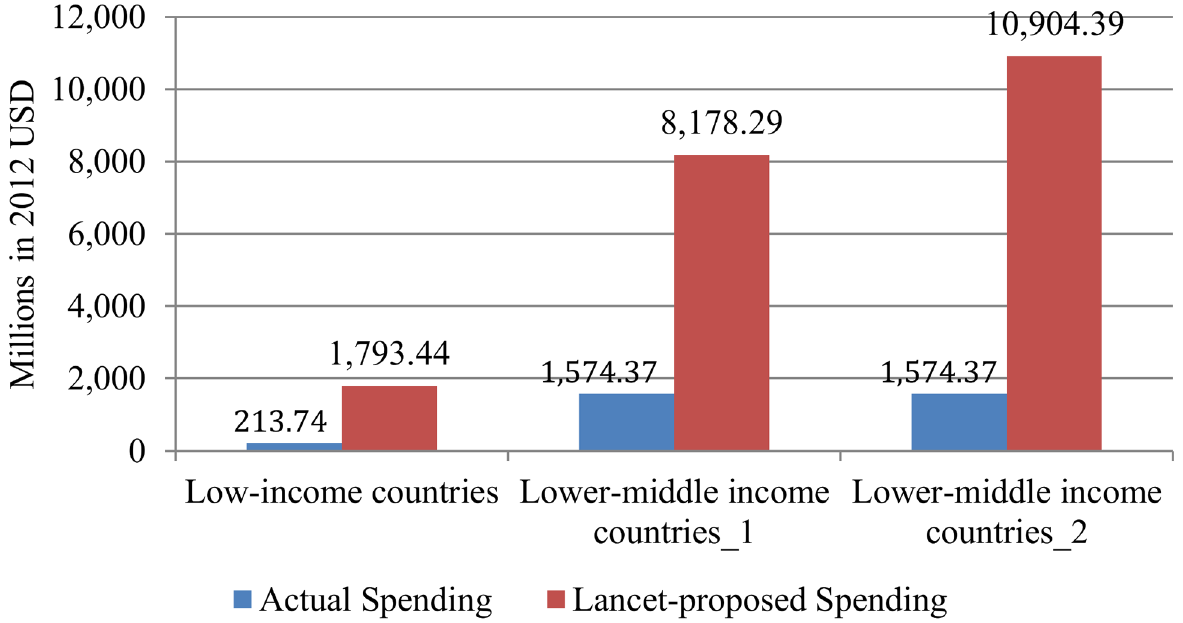
Fig 4. Financial gap between actual spending and spending proposed by the Lancet Global Mental Health Group (LGMHG). LIC: low-income country; LMIC: lower-middle-income country; LMIC_1: based on US$3 per capita LGMHG estimation; LMIC_2: based on US$4 per capita LGMHG estimation.